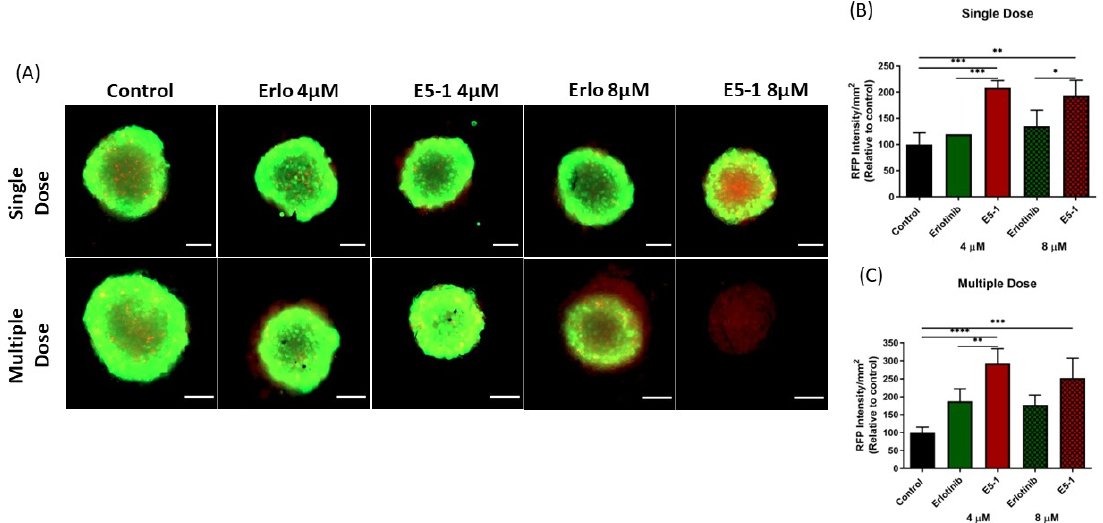
Figure 8. Effect of multi-dose treatment on the growth of 3D spheroid-tumor of A549 cells. Spheroid images taken after multiple dose treatment at day 0, 3, 9, and 15 for erlotinib and E5-1 nanoemulsion at 4 µM and 8 µM, Scale bar for the images represents 500 µm ( A ). The spheroids of A549 treated with E5-1 nanoemulsion showed significantly reduced spheroid volume in comparison to control and erlotinib after 15 days of treatment, as shown in the graph plots ( B ). Data represent mean ± SD (n = 6). Significance between the groups was analyzed by one-way ANOVA and Tukey’s multiple comparison test. **** p < 0.0001.